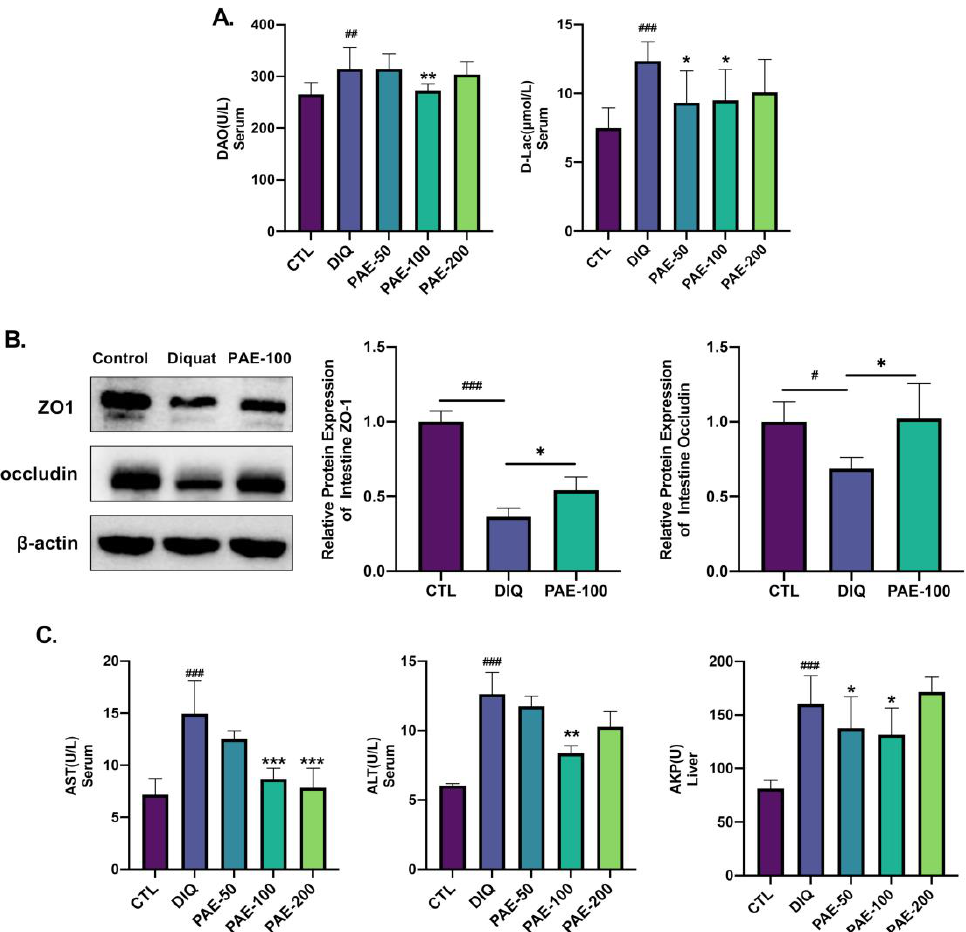
Figure 3. Effects of PAE on intestinal barrier and liver function in diquat-induced mice: ( A ) Analysis of intestinal permeability parameters (DAO, D-Lac) in serum by ELISA ( n = 8); ( B ) analysis of the relative protein expression level (ZO-1, occludin) in intestine by WB ( n = 3); ( C ) analysis of parameters of liver injuries (AST, ALT in serum, and AKP in liver) ( n = 8). All data were represented as means ± SD. # p < 0.05, ## p < 0.01, and ### p < 0.001 as compared with the CTL group; * p < 0.05, ** p < 0.01, and *** p < 0.001 as compared with DIQ group.